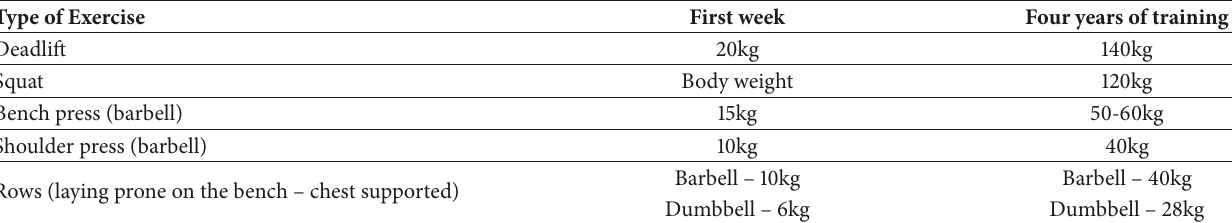
Table 1: Progress in strength of patient 1 in four years of training. All exercises consisted of 1-5 repetitions. First week: initial training program; four years of training: current training program.